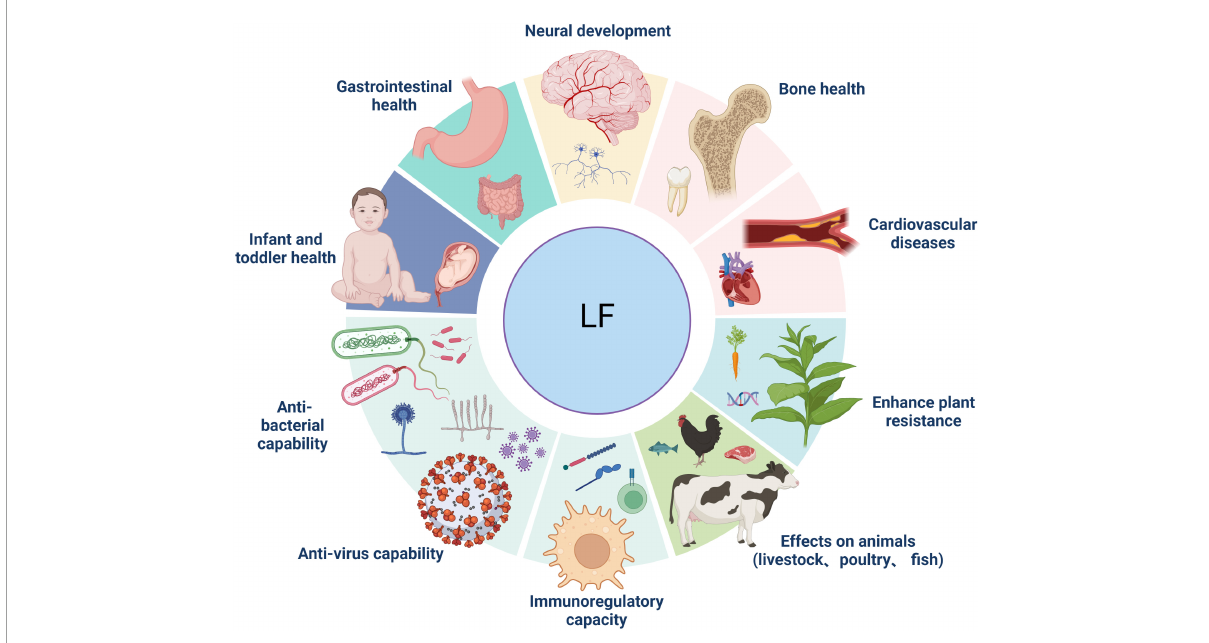
FIGURE5 Applications of lactoferrin in the treatment of human diseases and other